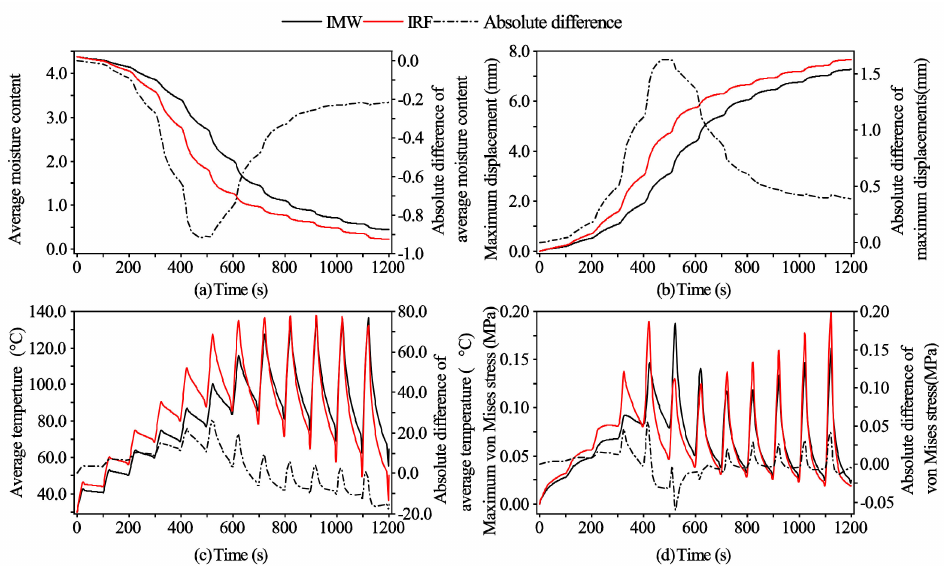
Figure 14. The comparison of IMW and IRF. ( a ) The average moisture content and absolute differences of IMW and IRF. ( b ) The maximum displacement and absolute differences of IMW and IRF. ( c ) The average temperature and absolute differences of IMW and IRF. ( d ) The maximum von Mises stress and absolute differences of IMW and